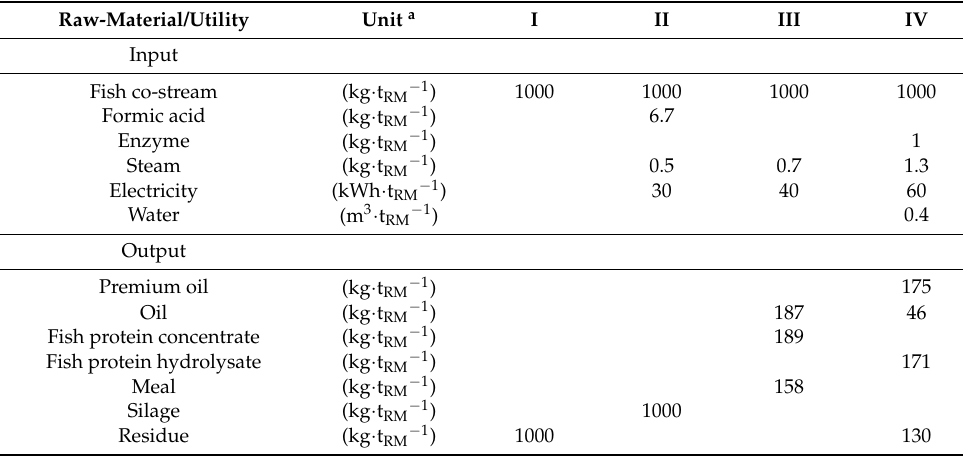
Table 1. Material and energy balance of the fish processing plant.